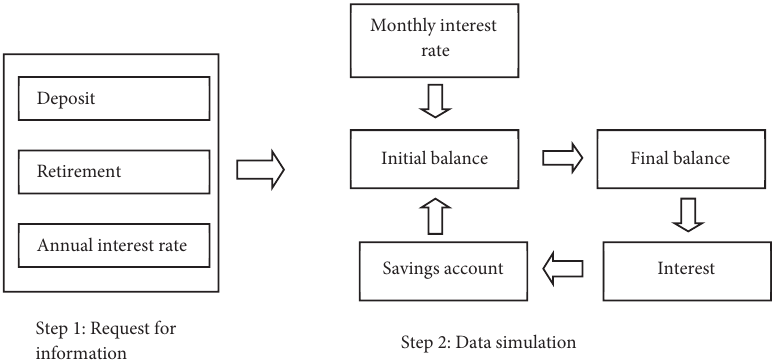
Figure 1. Creative educational virtual spaces of the web application for the teaching-learning process on bank savings (source: created by authors)